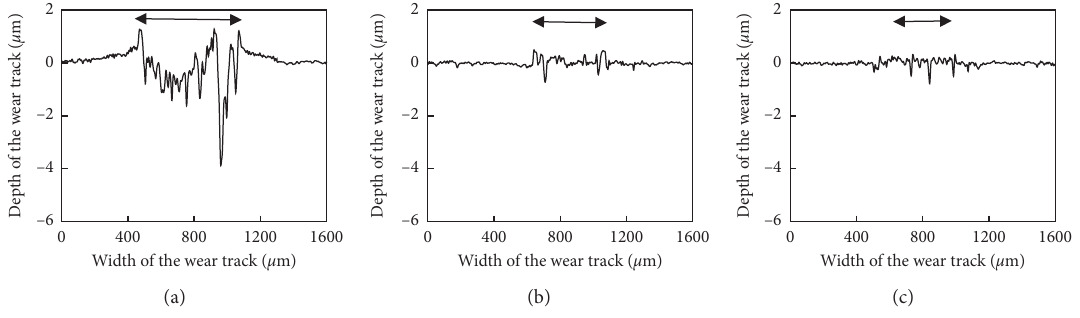
Figure 11: Profilometry plots of wear tracks for (a) RAW, (b) CQT, and (c) LQ